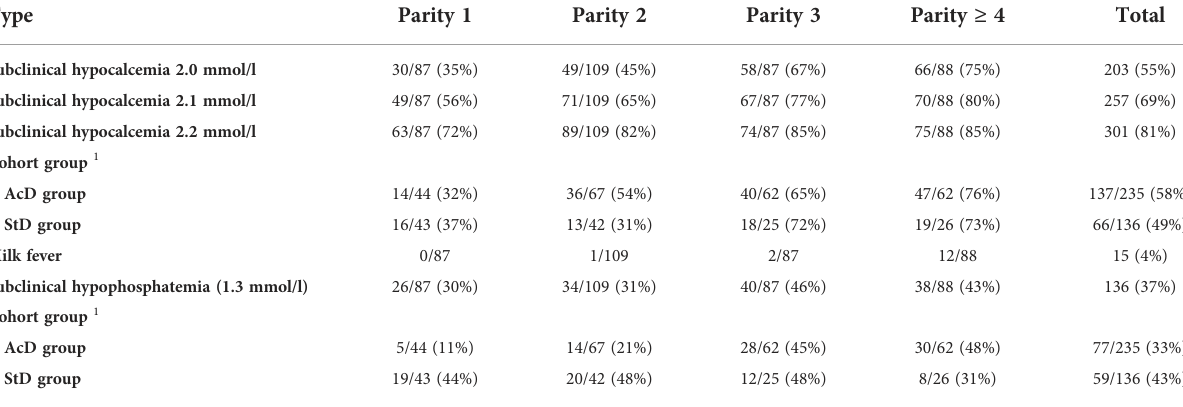
TABLE 1 Incidence of subclinical hypocalcemia (SHC), milk fever, and subclinical hypophosphatemia (SHP) in cows 24 to 48 h after parturition (no./total; % in parentheses) presented according to parity and the type of diet (acidi fi ed or standard) received in late gestation (n = 371